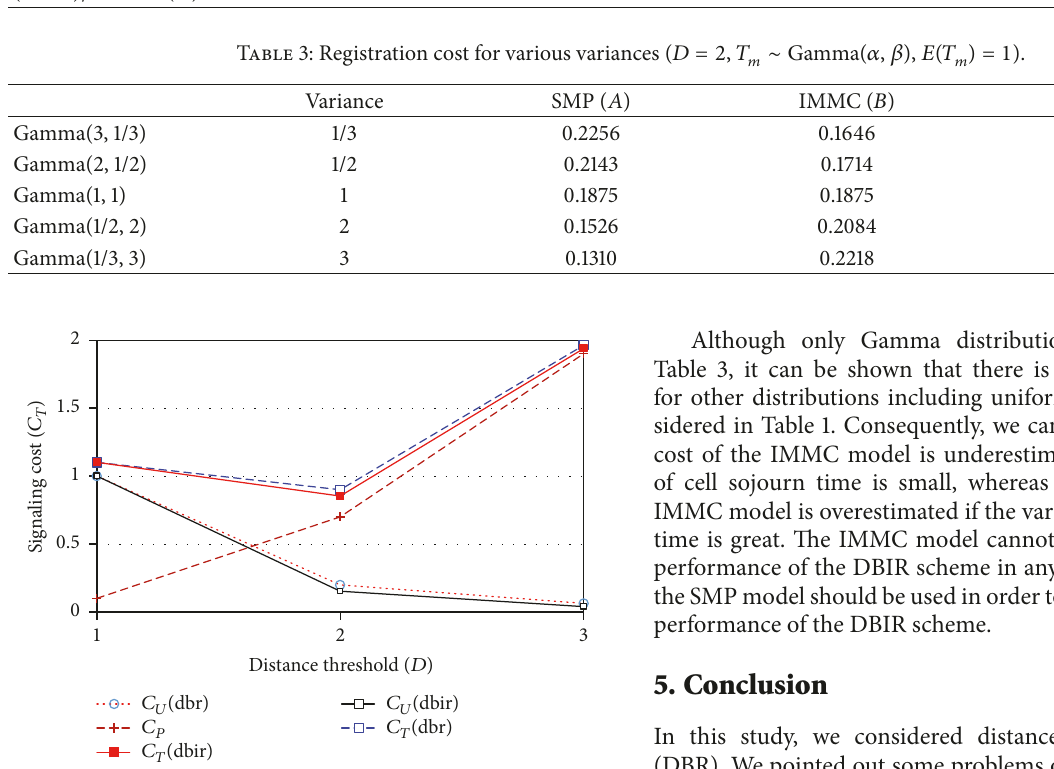
Figure 6: Signaling cost versus distance